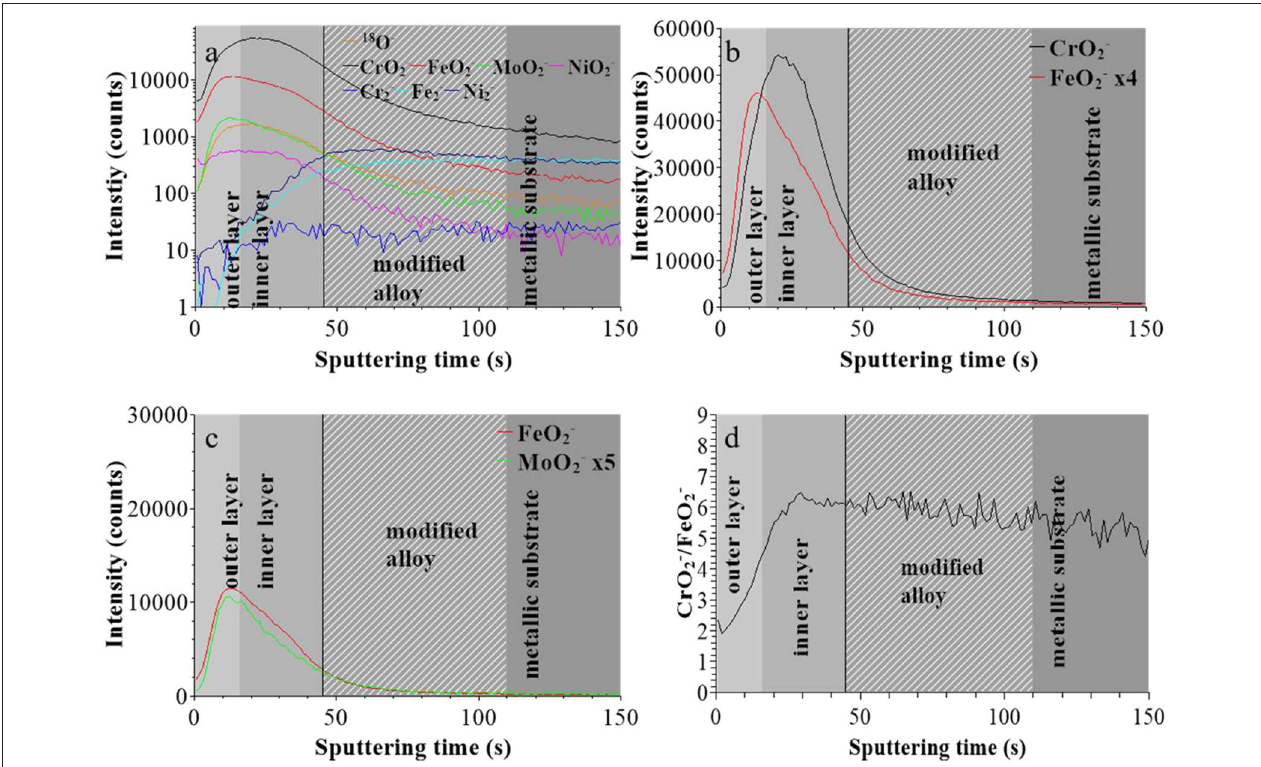
FIGURE 3 | ToF-SIMS depth profiles for 316L SS immersed in 0.05M H 2 SO 4 at U OCP for 30 min: (a) 18 O − , CrO − 2 , FeO − 2 , NiO − 2 , MoO − 2 , Cr − 2 , Fe − 2 , and Ni − 2 secondary ions, (b) CrO − 2 and FeO − 2 secondary ions, (c) FeO − 2 and MoO − 2 secondary ions, (d) CrO − 2 / FeO − 2 intensity ratio.